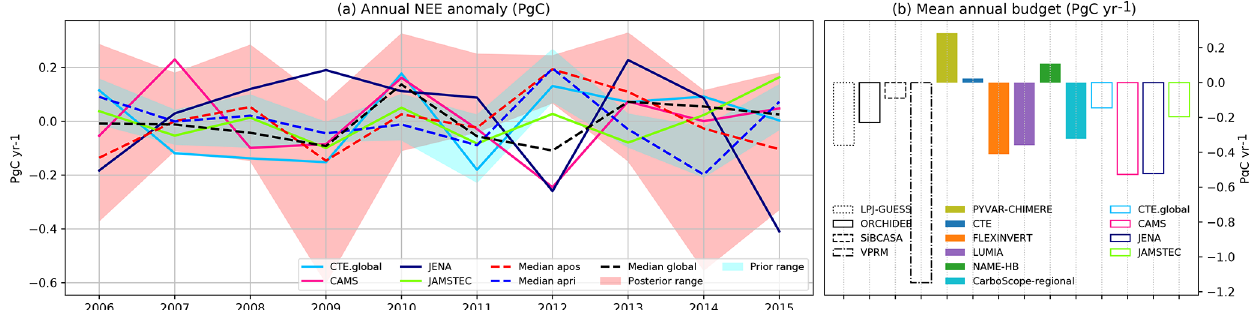
Figure 10. Comparison of the EUROCOM inversion ensemble with global inversions from the Global Carbon Project (Le Quéré et al., 2018). Panel (a) shows the annual NEE anomalies, with our prior and posterior ensembles shown as shaded areas, for the clarity of the figure. Panel (b) shows the mean annual budgets. The results from the global inversions were extracted for the exact EUROCOM domain on the global carbon atlas (http://www.globalcarbonatlas.org, last access: 6 August